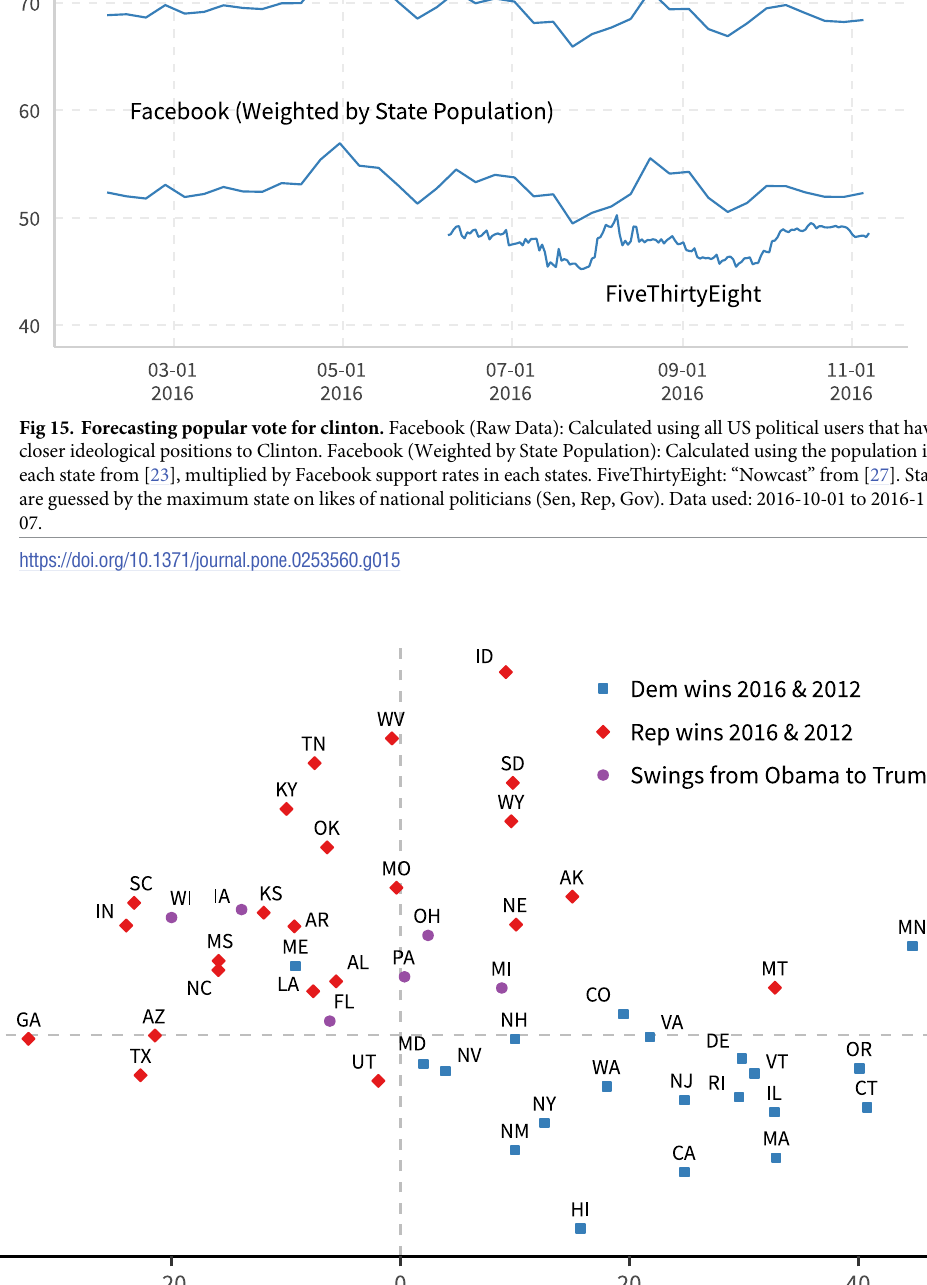
PLOS ONE | https://doi.org/10.1371/journal.pone.0253560 December1,